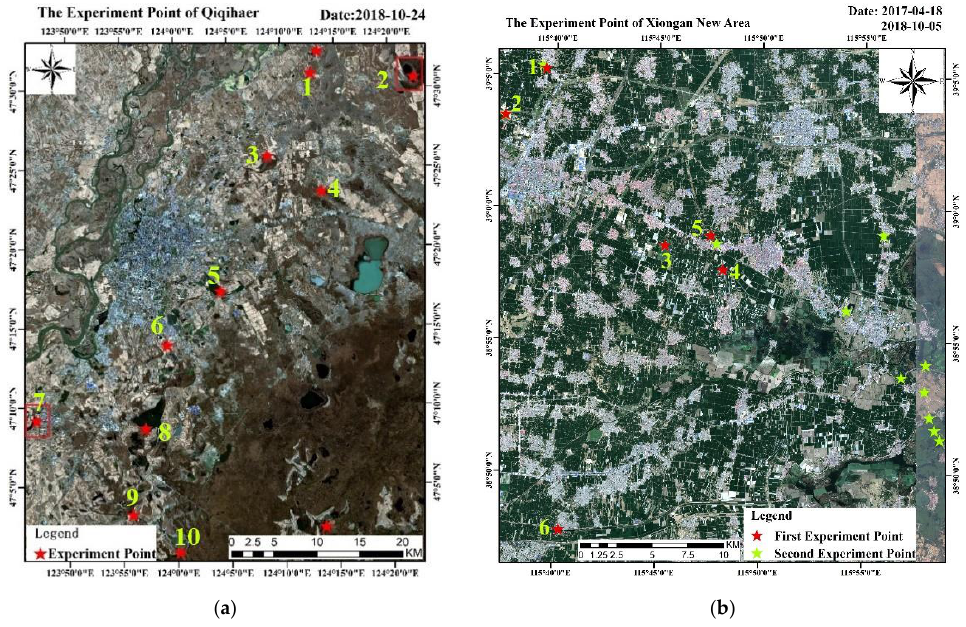
Figure 3. Test Sites at ( a ) Qiqihaer City and ( b ) the Xiong’an New Area. Note: In Qiqihar, samples 1-6 are general water bodies, and samples 7-10 are anomalous waters. In the Xiong’an New Area, samples 1-4 are general water bodies, and samples 5-6 are anomalous